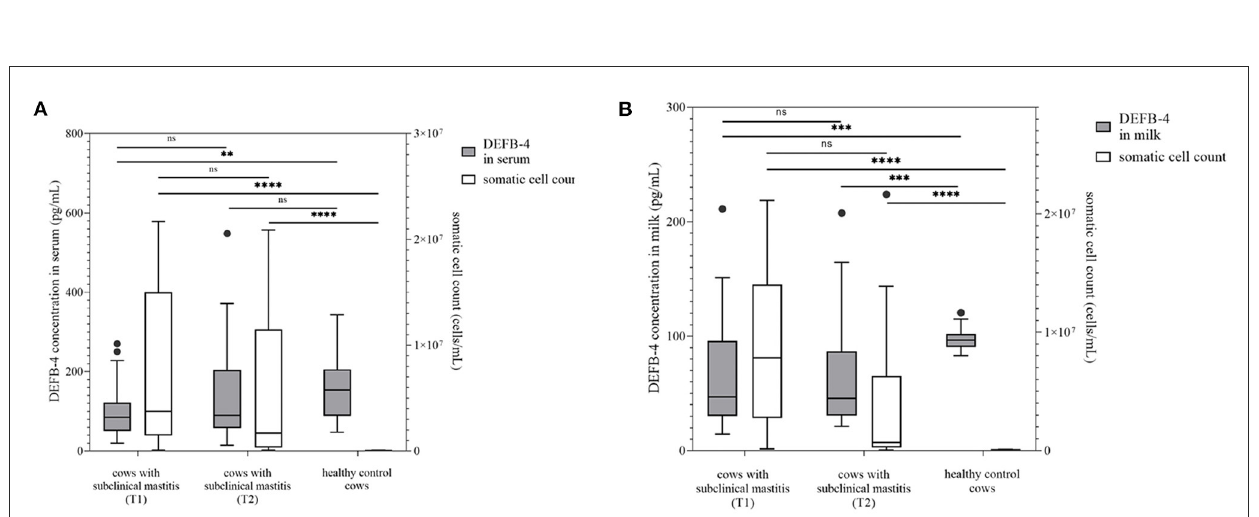
FIGURE2 DEFB-4 concentration grouped with the somatic cell count which is currently the standard parameter for the detection of mastitis. 25 cows with subclinical mastitis were tested at two different times and compared with a healthy control group. T1 marks the time of initial sampling and T2 the time of second sampling 12 days later. (A) demonstrates DEFB-4 concentrations in serum and (B) shows DEFB-4 concentrations in milk. Significant changes are marked by asterisks (*) whereas “ns” means “non-significant”. The significance level is set at p < 0.05.